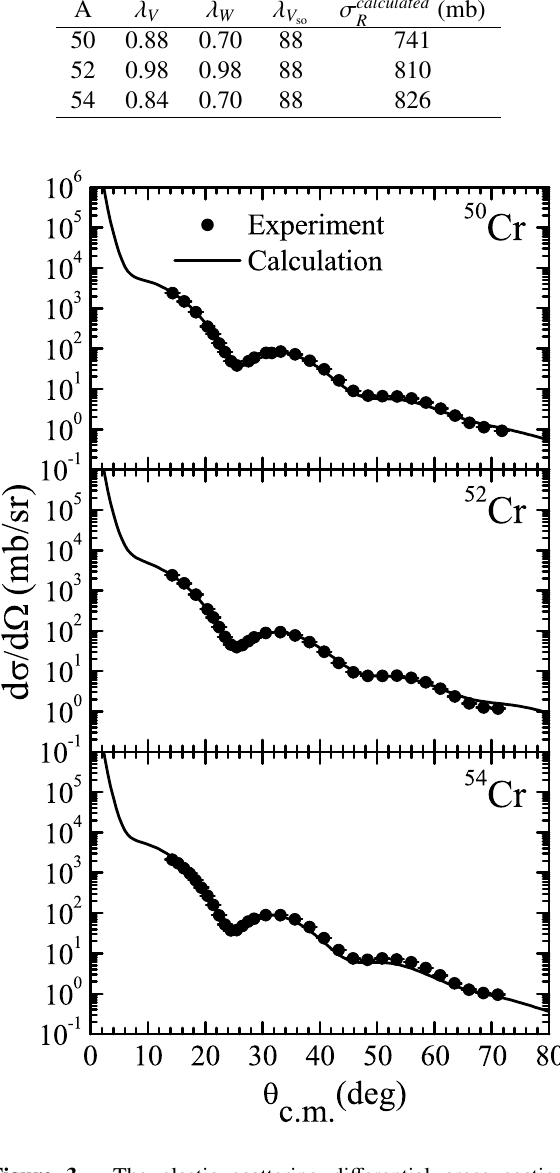
Figure 3. The elastic scattering di ff erential cross section ( d σ/ d Ω ) calculated using the best fit values of λ V , λ W and λ V for protons with incident energy of 65 MeV scattering from sta- ble even Cr isotopes. The corresponding data [21] are also plot-